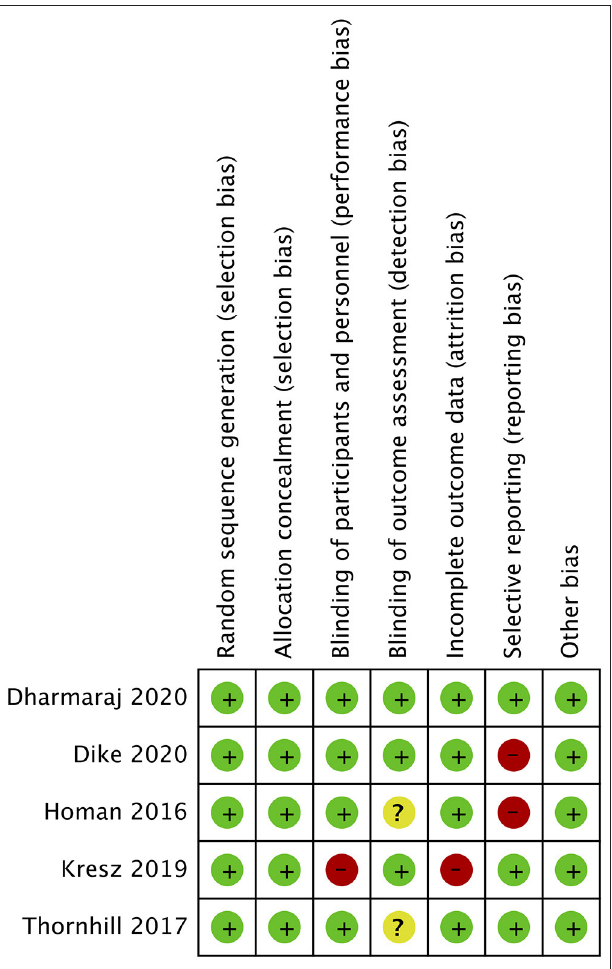
the degree of abdominal distention in study groups.